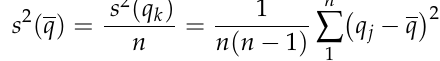
Table 4. Measurement instrument uncertainty (type B). Parameter Uncertainty Temperature